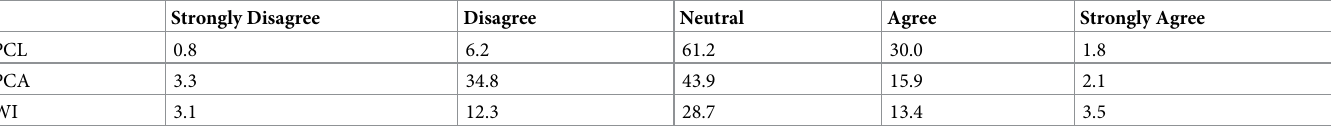
Table 2. Overall level of agreement with extreme political